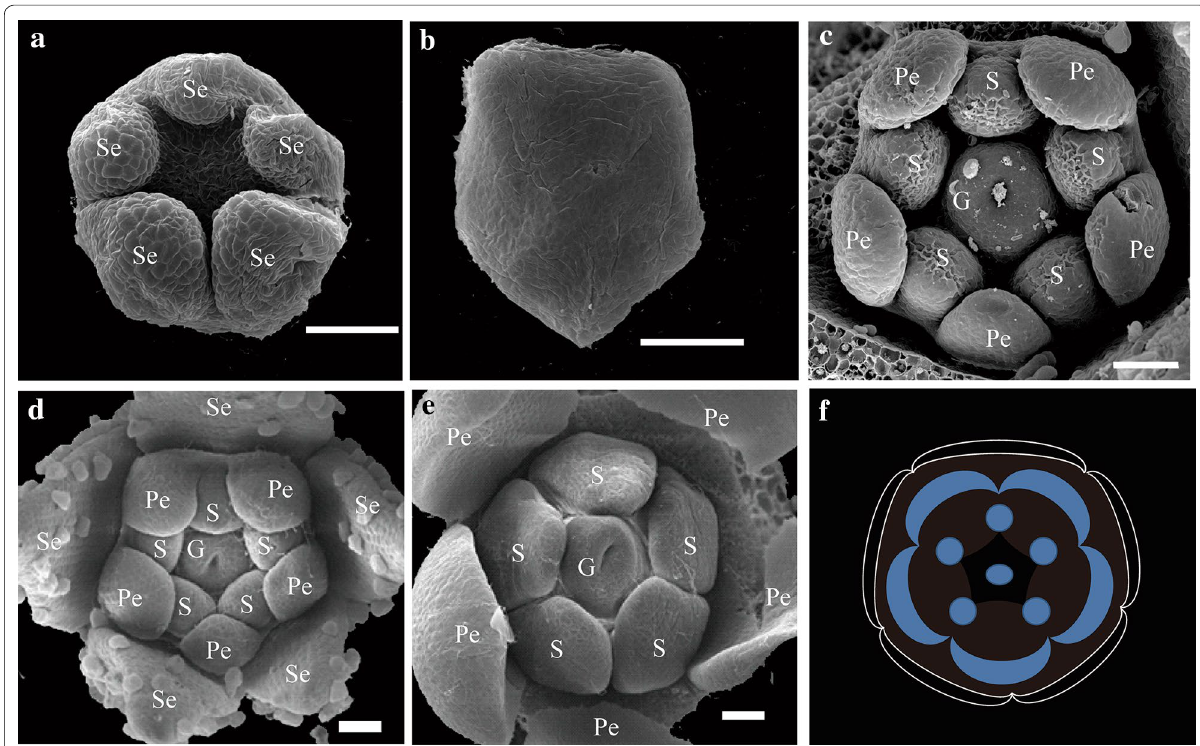
Fig. 2 The SEM photos of morphological development process of Conandron ramondioides flowers. Zygomorphy was observed at Stage 3 of sepal whorl. Definition of developmental stages of C. ramondioides based on (Harrison et al. 1999). a Stage 3, the sepals form as bulges at the points of the pentagon. b Stage 4, the sepals grow, while the floral meristem remains undifferentiated. c Stage 6, the corolla and androecium grow, and the gynoecium initiates. d Stage 7A, petal growth. e Stage 7B, androecium and gynoecium development. f Floral diagram of C. ramondioides . Se Sepals, Pe petals, S stamen, G gynoecium. Scale bar represents 50